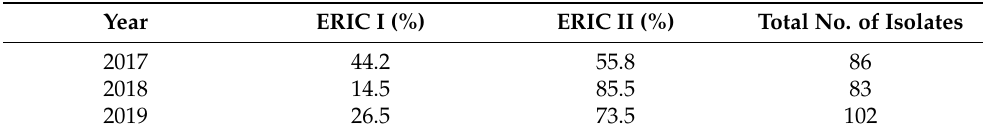
Figure 1. Spatial ( A ) and temporal ( B ) distribution of ERIC types in Slovenia. A total of 506 Paenibacillus larvae isolates from the 2017–2019 period were included into the analysis. Each circle represents an apiary ( A ) or isolate ( B ) and is colored according to ERIC type. Note that more than one isolate per apiary was obtained in 107 cases. Table 1. Prevalence of the ERIC types over time. The prevalence was calculated on a set of 271 Paenibacillus larvae isolates originating from different apiaries and belonging to different ERIC types (for details, see Table